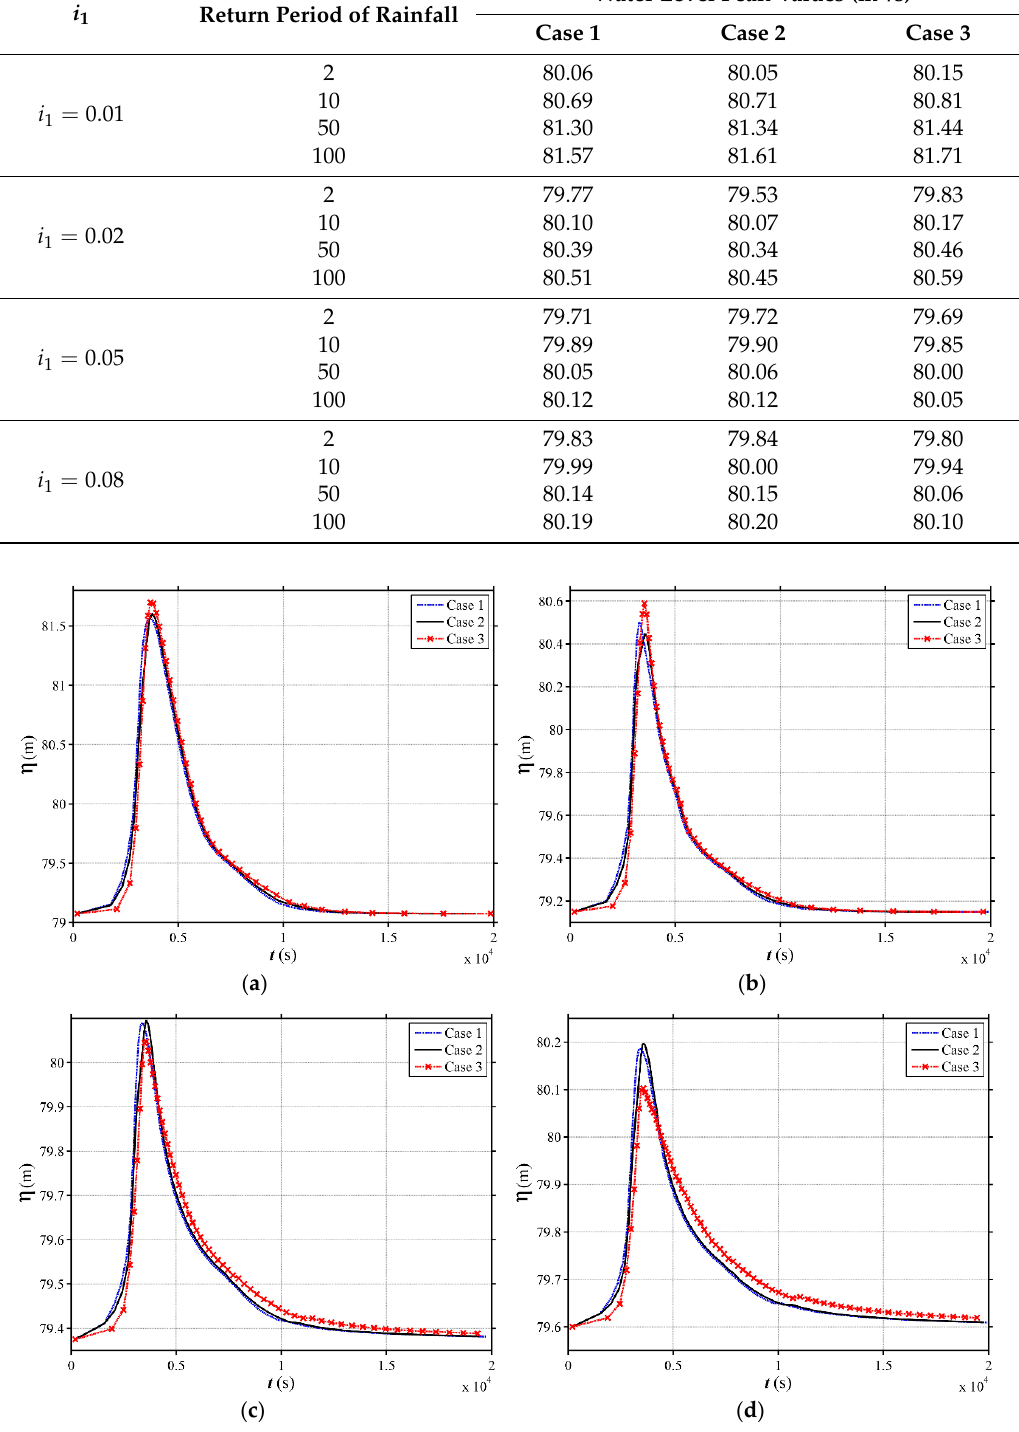
Figure 10. Simulated water level evolution at the outlet for different land use scenarios in the V-shaped catchment under the 100-year rainfall event. ( a ) i 1 = 0.01; ( b ) i 1 = 0.02; ( c ) i 1 = 0.05; ( d ) i 1 = 0.08. In a sum, with the channel slope ( i 1 ) lower than 0.05, the forest located in the middle of the Table 2. Comparison of peak discharge for different land use scenarios. catchment slope could most effectively attenuate the flood, while that in the downstream causes the most severe flood. When the channel slope ( i 1 ) higher than 0.05, the forest located in the downstream